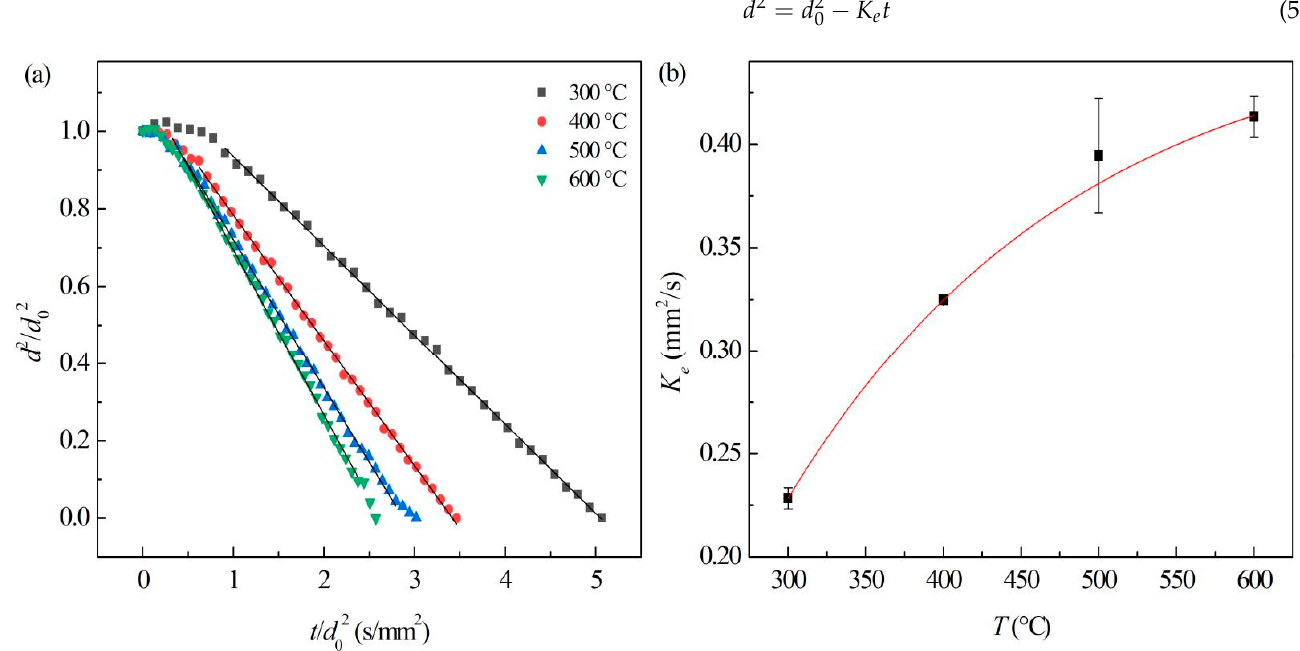
Figure 8. Evaporation of JP-10 at different ambient temperatures. ( a ) Variation of droplet diameter with the evaporation time, ( b ) evaporation rates at different ambient temperatures.